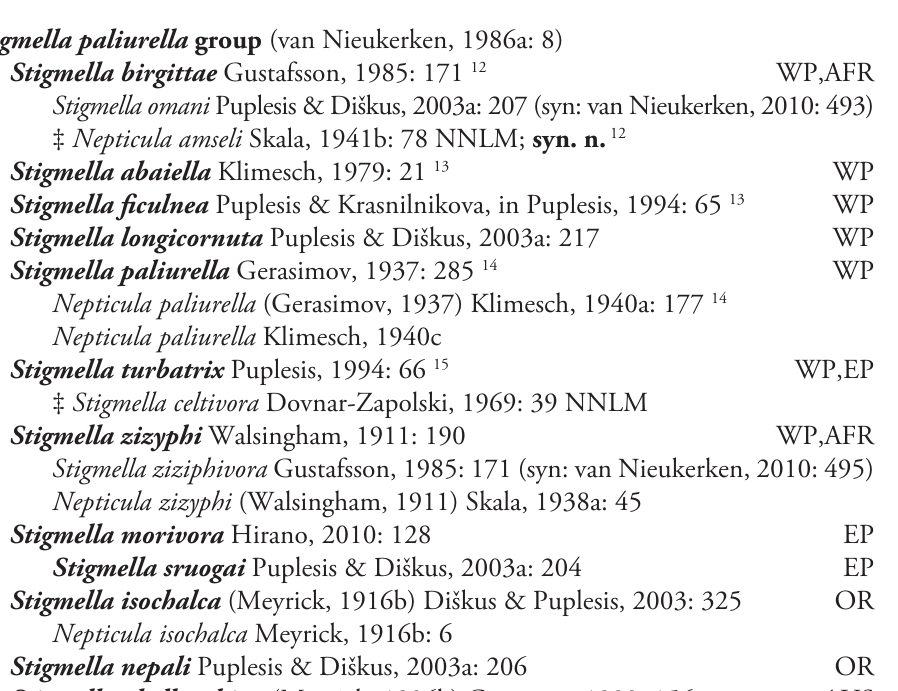
Stigmella paliurella group (van Nieukerken, 1986a: 8) Stigmella birgittae Gustafsson, 1985: 171 12 WP,AFR Stigmella omani Puplesis & Diškus, 2003a: 207 (syn: van Nieukerken, 2010: 493) ‡ Nepticula amseli Skala, 1941b: 78 NNLM; syn. n. 12 Stigmella abaiella Klimesch, 1979: 21 13 WP Stigmella ficulnea Puplesis & Krasnilnikova, in Puplesis, 1994: 65 13 WP Stigmella longicornuta Puplesis & Diškus, 2003a: 217 WP Stigmella paliurella Gerasimov, 1937: 285 14 WP